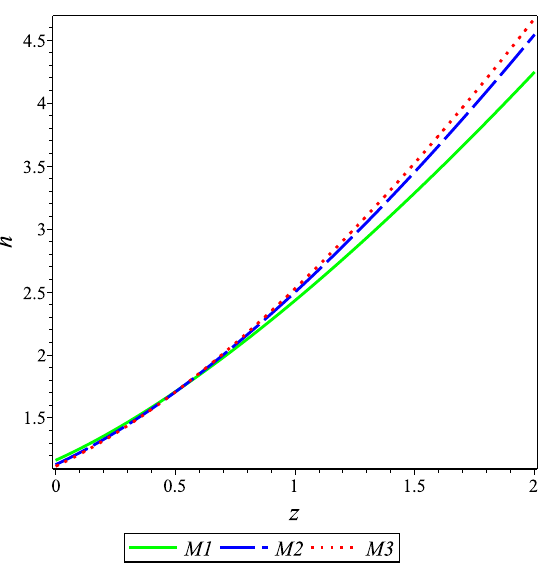
Figure 1. The normalized expansion rate, h (39), versus redshift, z , for three observational models M1, M2, and M3. See text for details.